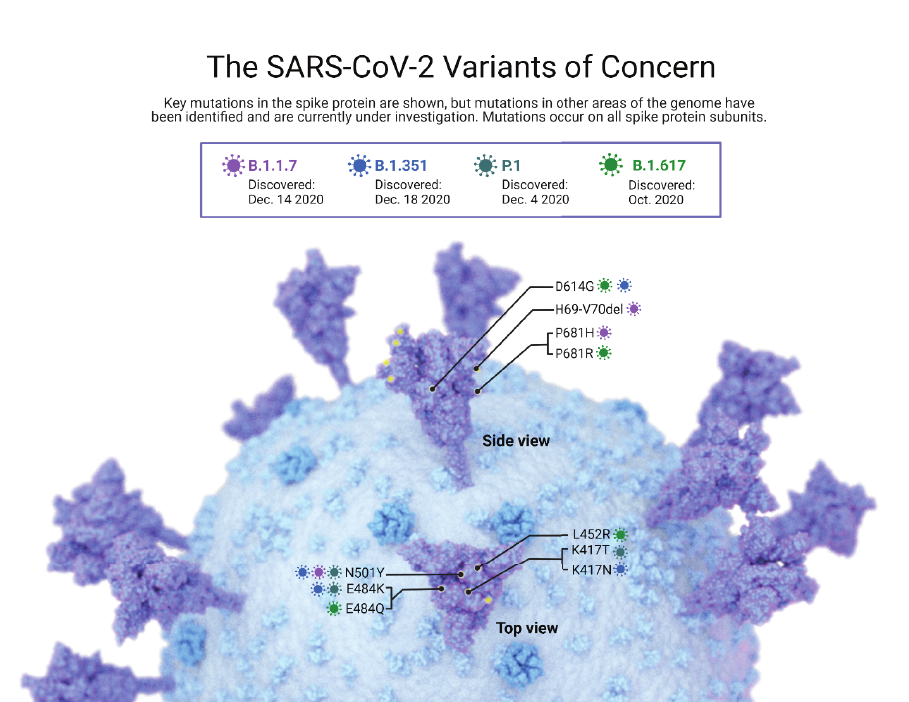
Figure 2 : Mutations of S protein subunits that characterize the variants of concerns: B.1.1.7 (Alpha), B.1.351 (Beta), P.1 (Gamma), and B.1.617 (Delta) variants. The N501Y and E484K are common mutations of S protein possessed by SARS-CoV-2 variants. Created with